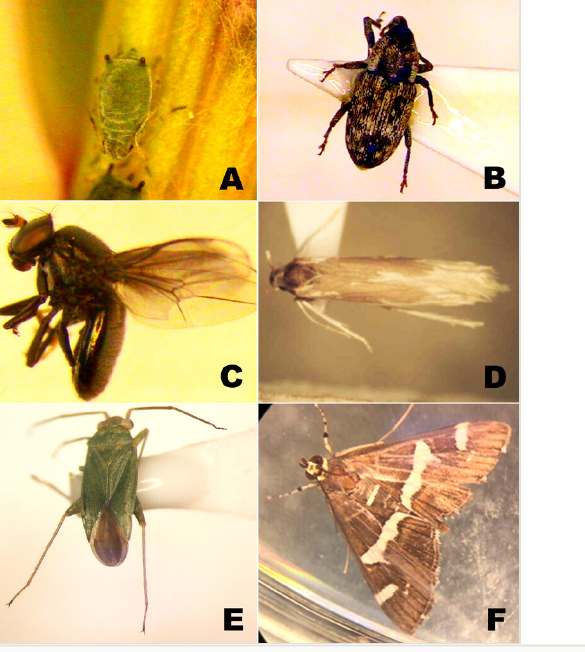
Figure 2. Insects found on Suaeda plants. A A nymph of Aphis sp. (Hemiptera: Aphididae) found on